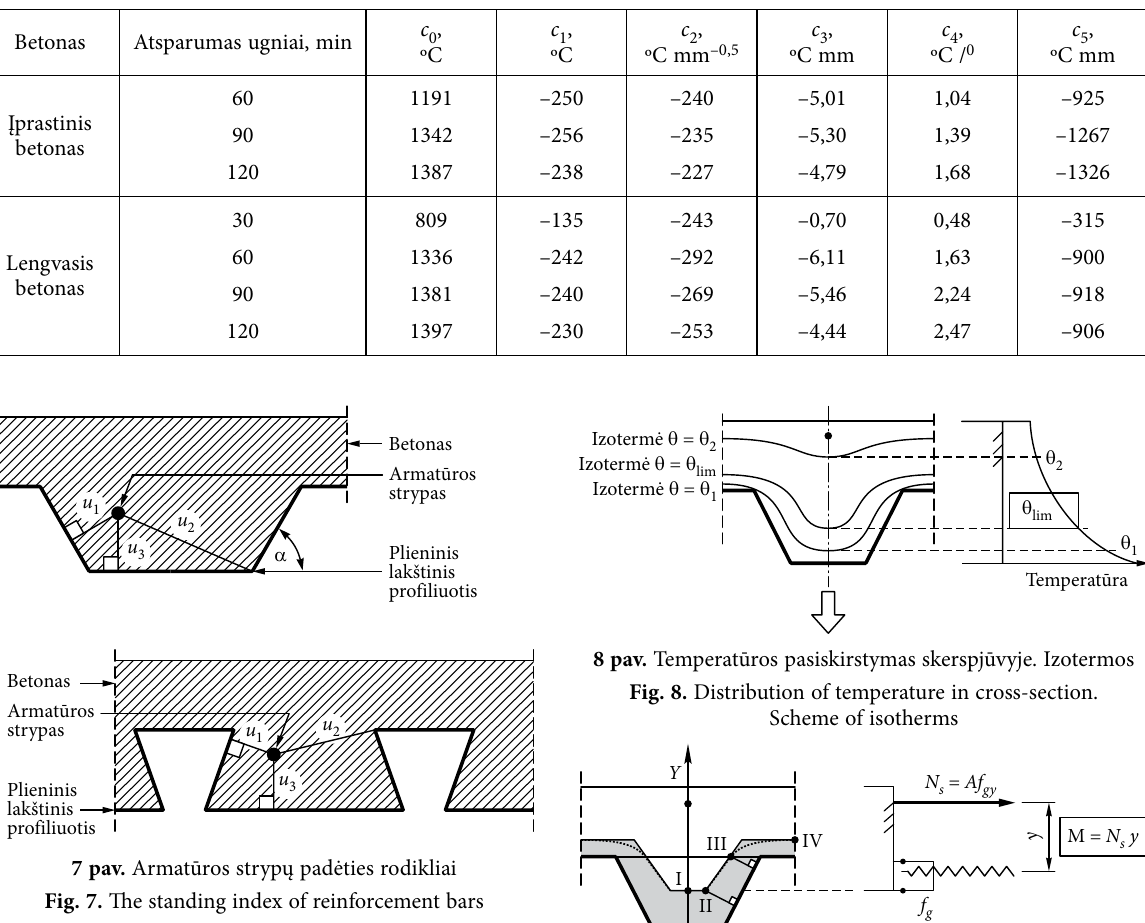
Table 3. Coefficients for temperature evaluation in reinforcement bars